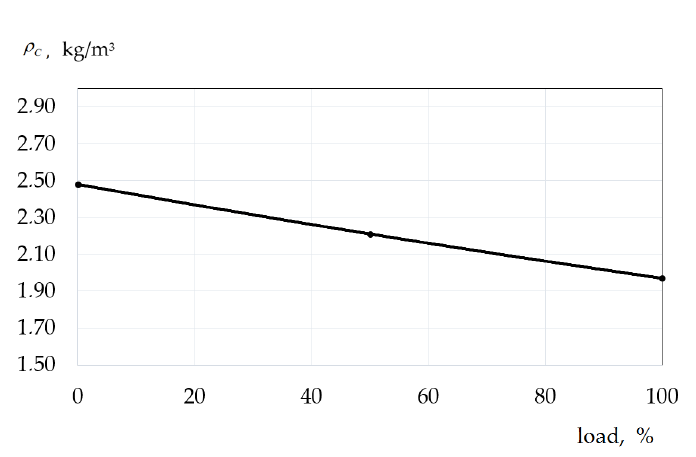
Figure 4. Dependence of the density of combustion products behind the combustion chamber on the load value.